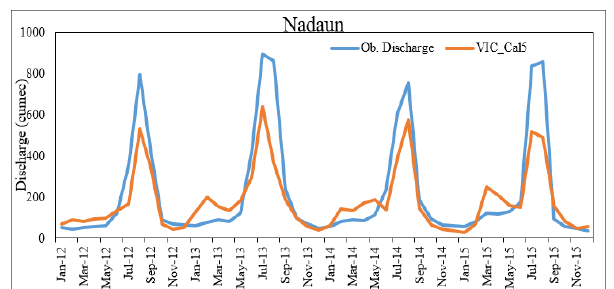
Figure 11 Validation plot of Simulated and observed Discharge at Nadaun